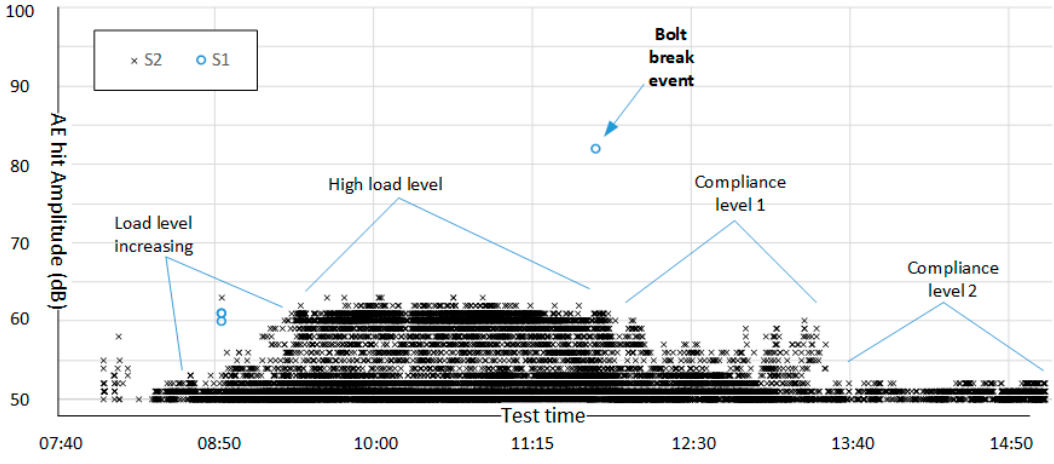
Figure 9. AE amplitude distribution for blade test during bolt failure incident.